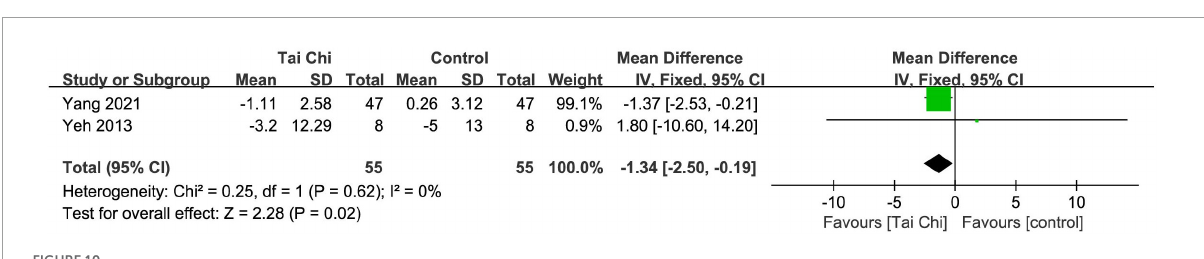
FIGURE10 Meta-analysis of TUGT in the Tai Chi group vs. the control group. CI, confidence interval; IV, inverse variance; SD, standard deviation.